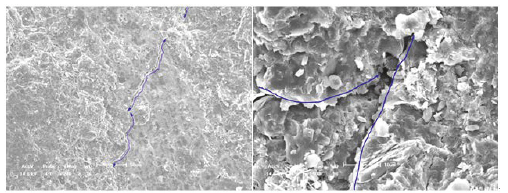
Figure 8: Intersection mode of microcracks of shale under tensile failure.